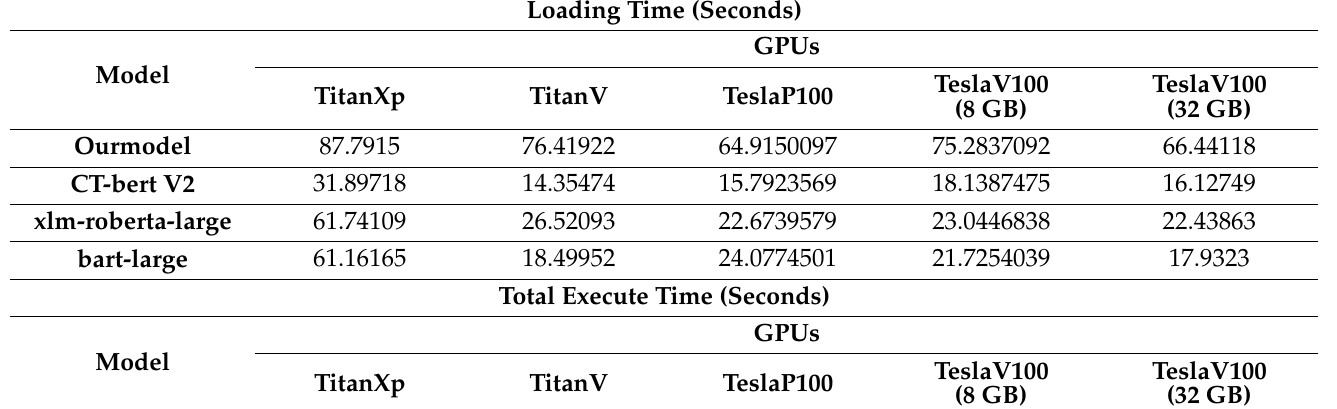
Table 11. Loading time and total execution time for all models on different GPUs.